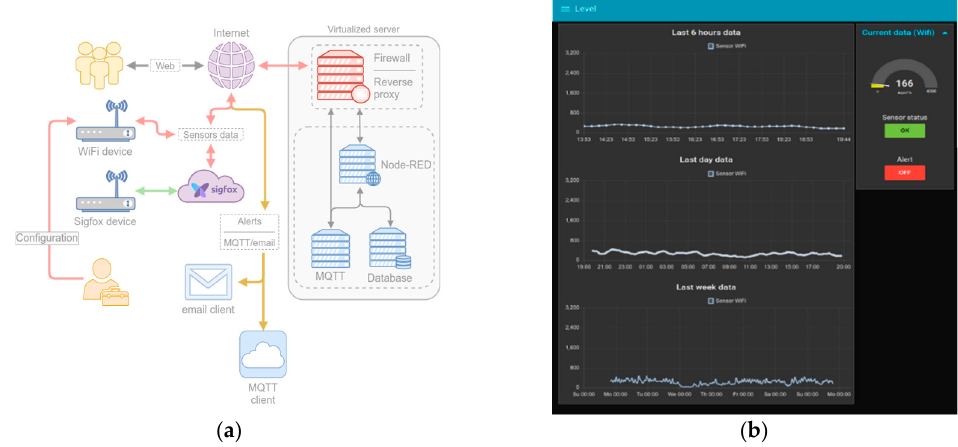
Figure 2. ( a ) Architecture of the radon detection and alert system. ( b ) System’s web